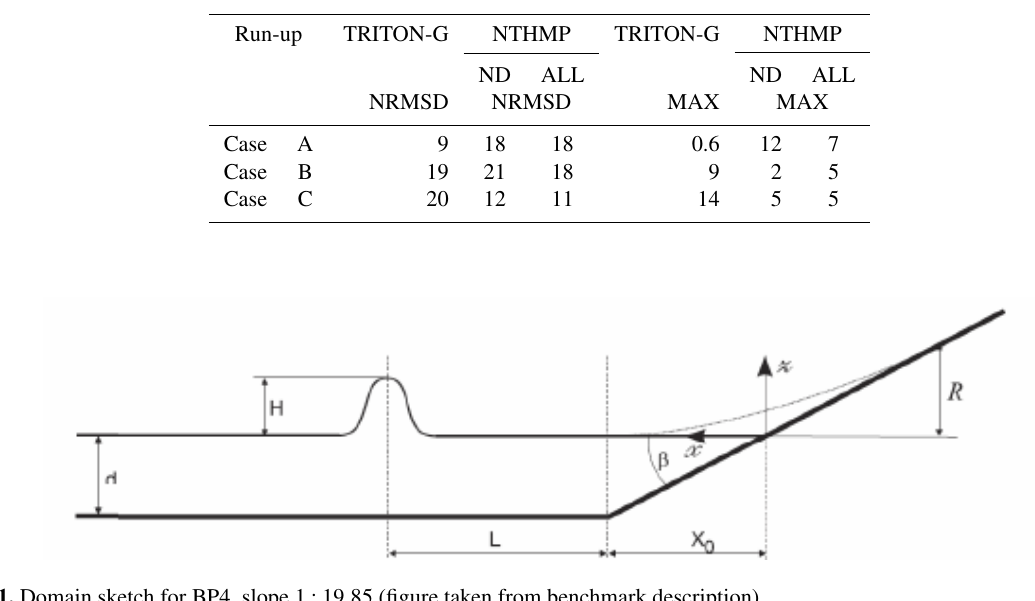
Table A4. Run-up TRITON-G model errors with respect to laboratory experiment data for cases A–C. Mean values obtained for the per- forming NTHMP models is separated in non-dispersive models (ND) and all models (ALL) and presented for better comparison.